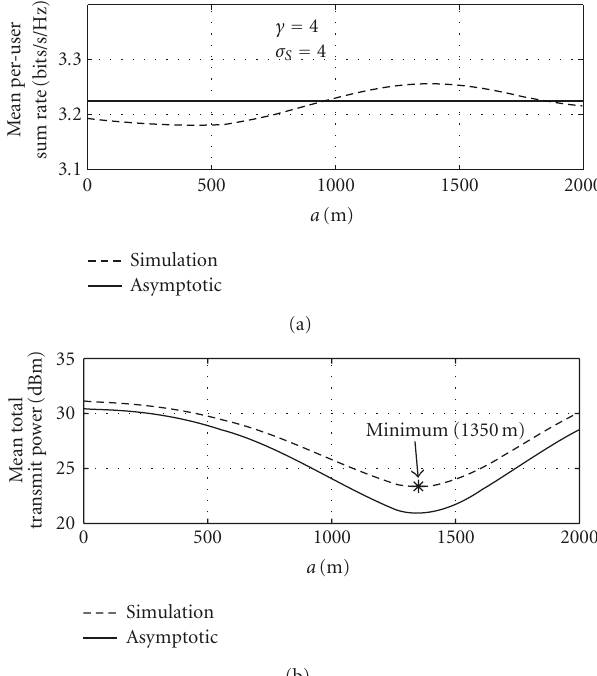
Figure 5: Simulation results for a practical system scale ( N = K =